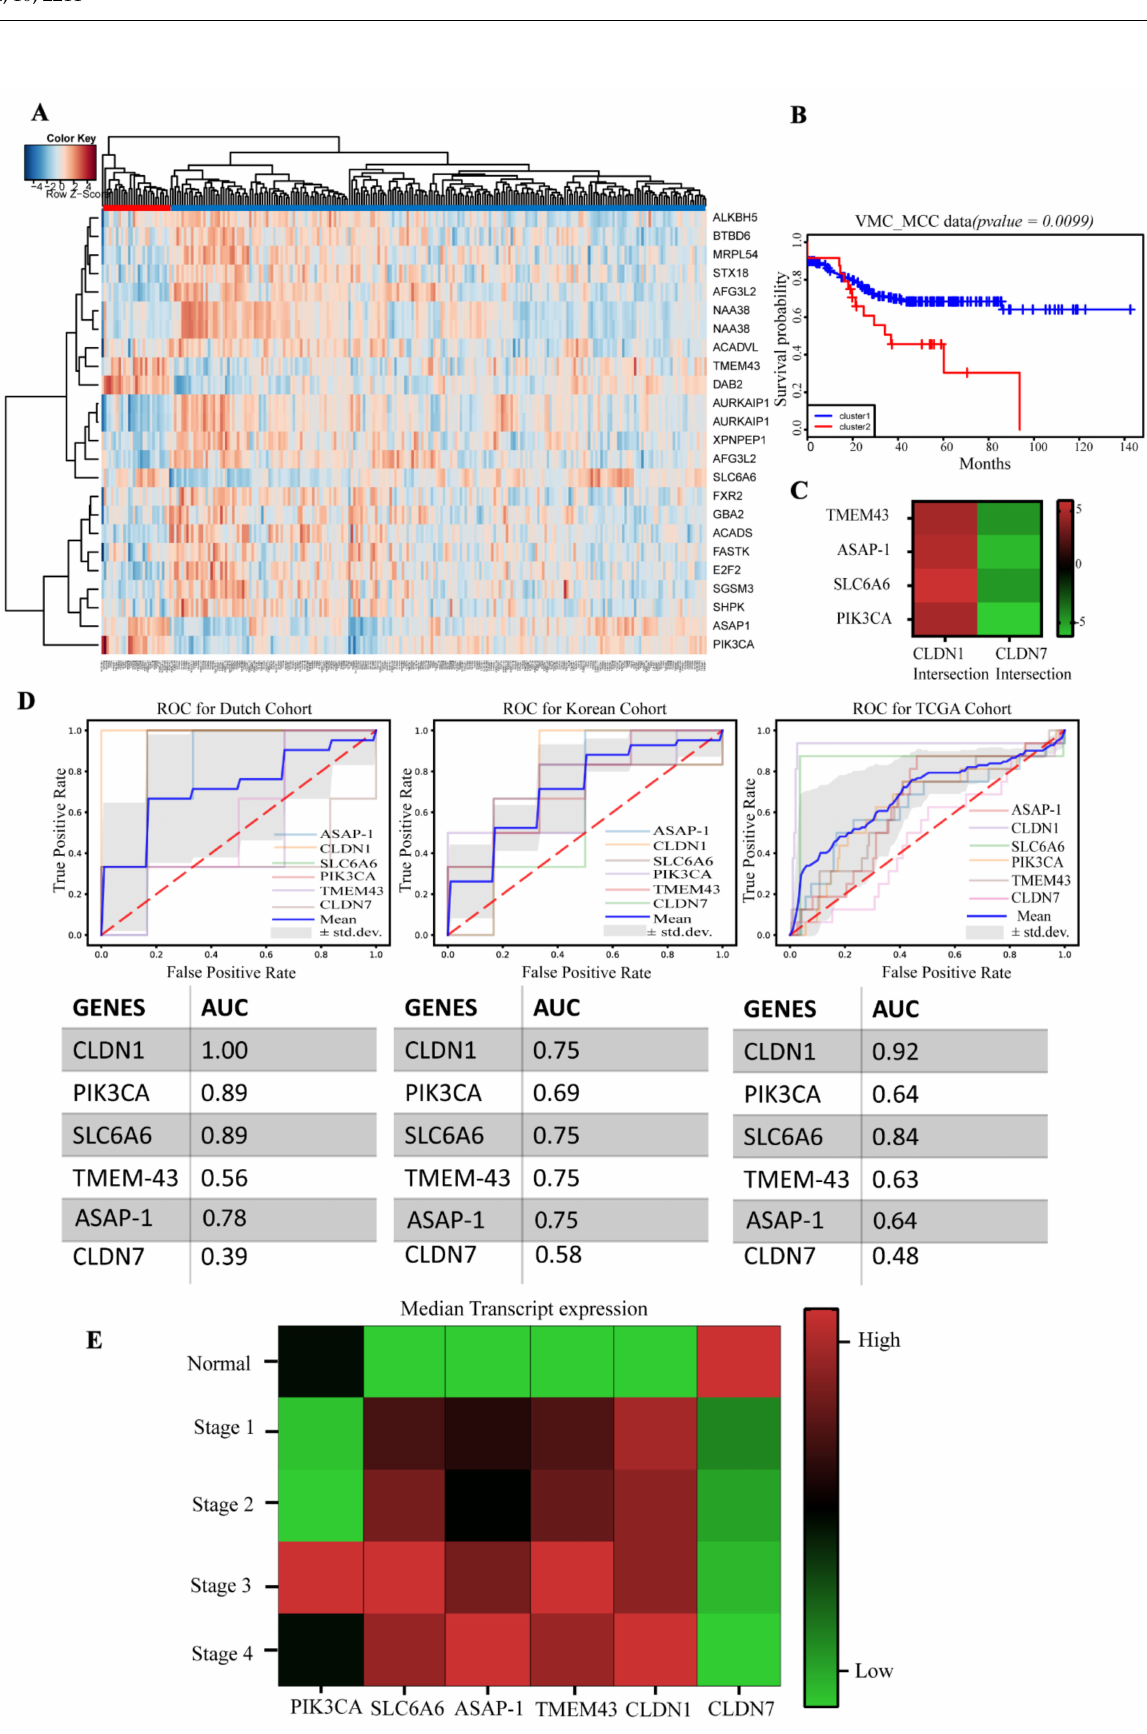
Figure 1. Hierarchical clustering analysis, impact on survival and performance of the genes: ( A ) Unsupervised hierarchal clustering of genes correlated with CLDN1 and CLDN7 as represented by heat map. The color range from blue to